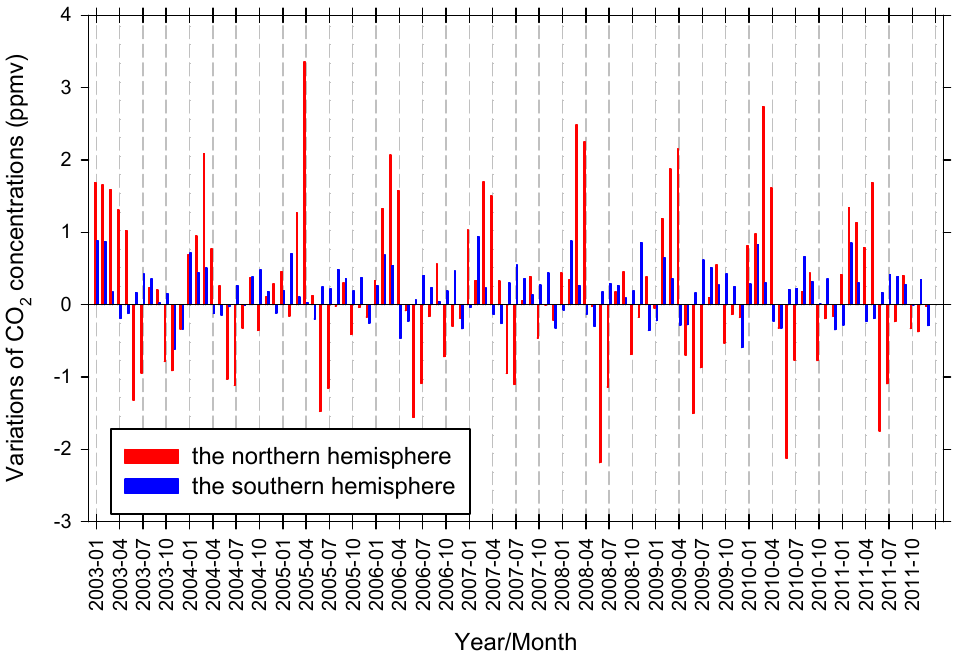
Figure 14. The amplitude of monthly average CO 2 concentration retrieved from the AIRS in the Northern (red) and Southern (blue) Hemisphere.